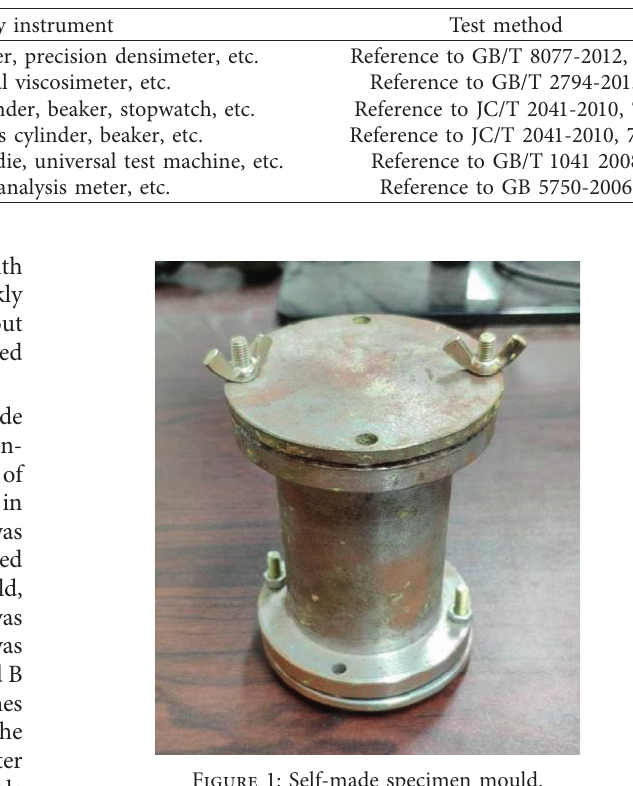
Table 3: Grout performance test.